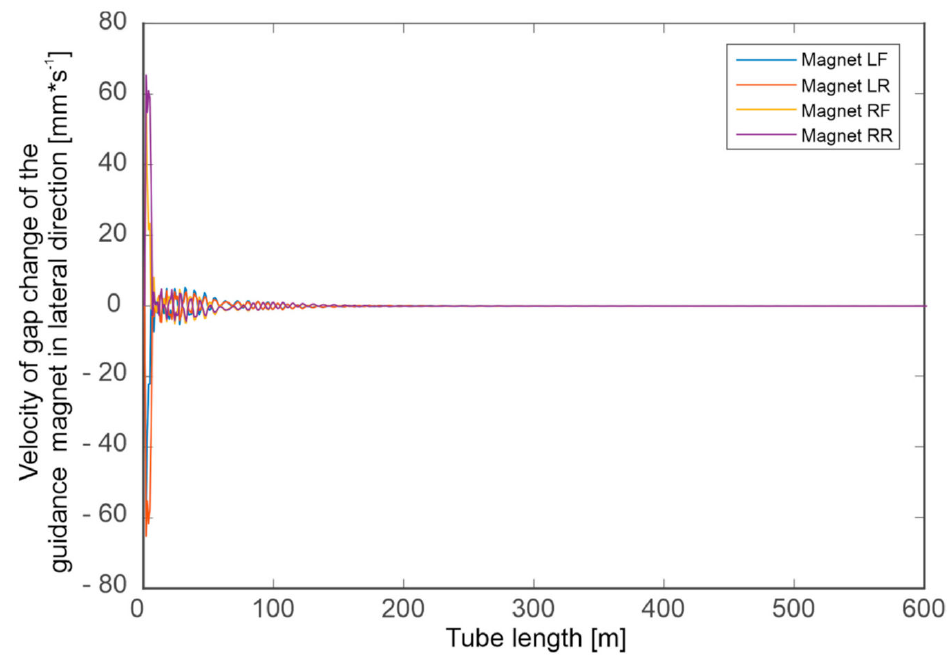
Figure 13. The speed of the gap width change on the guidance magnet in the lateral direction obtained at the capsule speed of 2000 km /